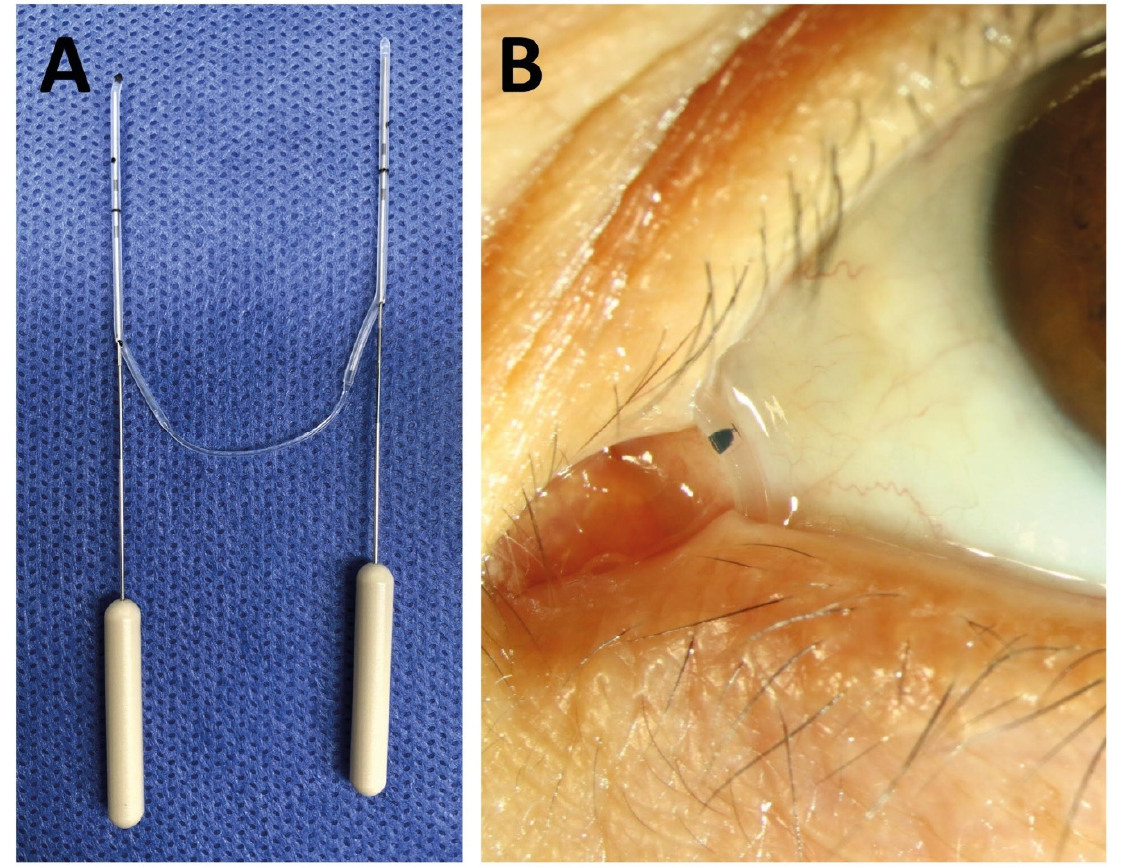
Figure 1. Picture of the Nunchaku tube before implantation ( A ) and when implanted ( B